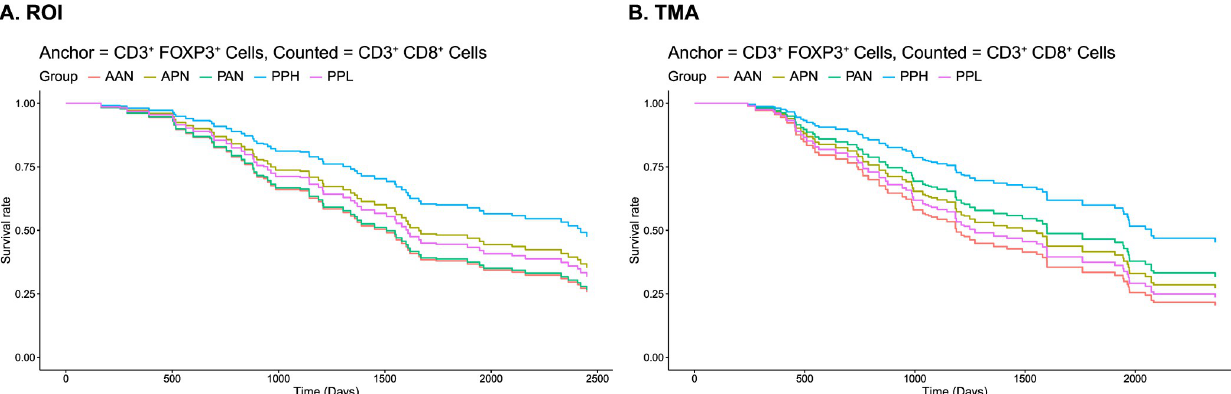
Fig 4. Predicted survival curves from Cox proportional hazard models for the degree of co-occurrence of CD3+FOXP3+ and CD3+CD8+ cells was based the permutation-based estimate of Ripley’s K under CSR (i.e., observed Ripley’s K–the mean of the empirical distribution of Ripley’s K under CSR); (A) results from intra-tumoral ROIs (93 subjects, 260 samples); (B) results from tumor compartment of TMAs (94 subjects, 263 samples). Models adjusted for age at diagnosis and stage within a repeated measures analysis